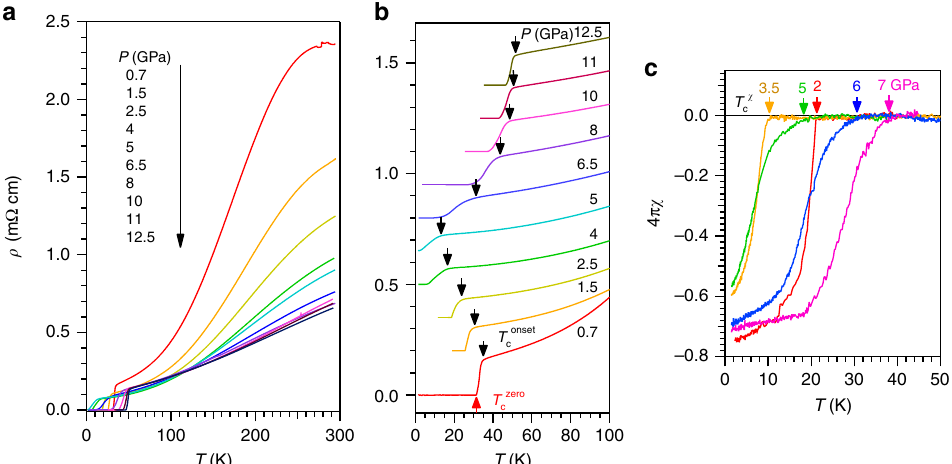
Fig. 1 High-pressure resistivity and AC magnetic susceptibility for (Li 1 − x Fe x )OHFe 1 − y Se. a ρ ( T ) curves in the whole temperature range illustrating the overall behaviors under pressure up to 12.5 GPa. b ρ ( T ) curves below 100 K illustrating the variation with pressure of the superconducting transition temperatures. Except for data at 0.7 GPa, all other curves in b have been vertically shifted for clarity. The onset T c onset (down-pointing arrow) was determined as the temperature where resistivity starts to deviate from the extrapolated normal-state behavior, while the T c zero (up-pointing arrow) was determined as the zero-resistivity temperature. c 4 πχ ( T ) curves measured under different pressures up to 7 GPa. The superconducting diamagnetic signal appears below T c